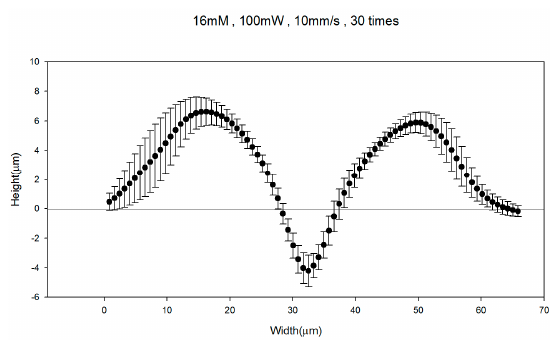
Figure 6. Energy dispersive X-Ray analysis (EDX) elemental analyses.